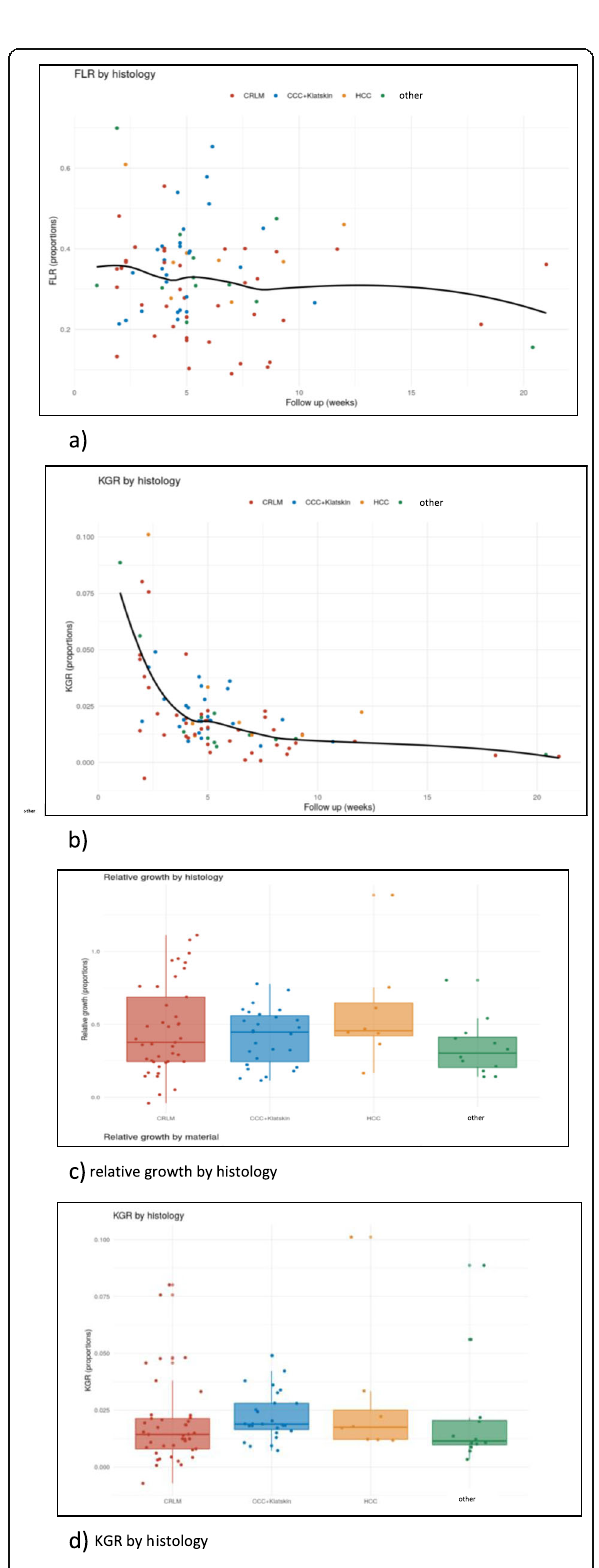
Fig. 2 Hypertrophy analysis by different histologies: a : Proportional FLR by histology and follow up time (weeks). Each point displays the follow up measurement of one patient. The black line represents a smoothed local regression curve (across histologies). b : Proportional KGR by histology and follow up time (weeks). Each point displays the follow up measurement of one patient. The black line represents a smoothed local regression curve (across histologies). c and d : The relative growth and the KGR are given in box- plots: In our subgroup analysis we found a median relative growth of the FLR in the CRLM group of 52% (SD 43%), in the group of central bile duct tumors of 37% (SD 18%) and in the HCC group of 58% (SD 37%). c relative growth by histology. d KGR by